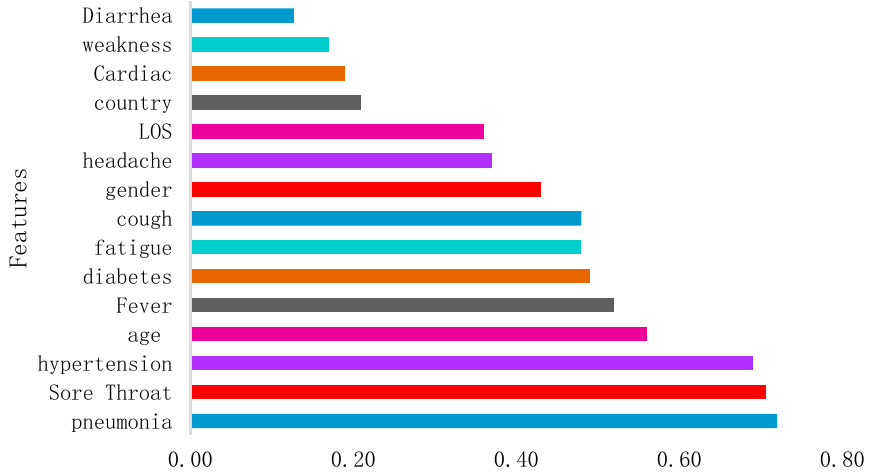
Figure 3. Selected features correlation in the dataset.